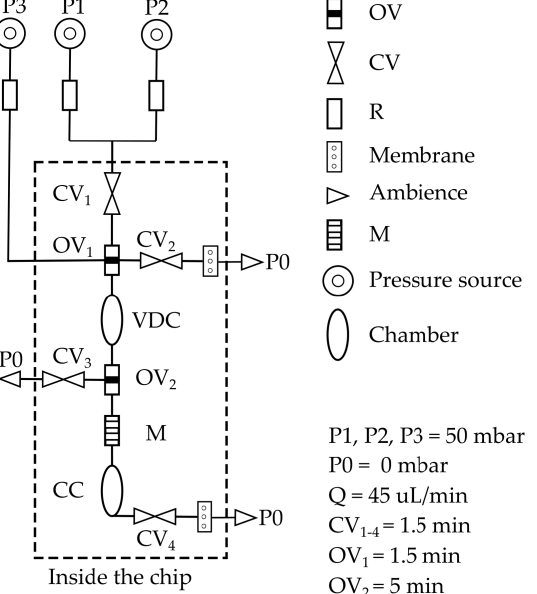
Figure 6. Circuit schematic of the application chip showing the building elements and their arrangements. M—3D micromixer, CV—closing valve, OV—opening valve, VDC—volume definition chamber, CC—collecting chamber, P—pressure, R—resister, Q—flow rate. The opening and